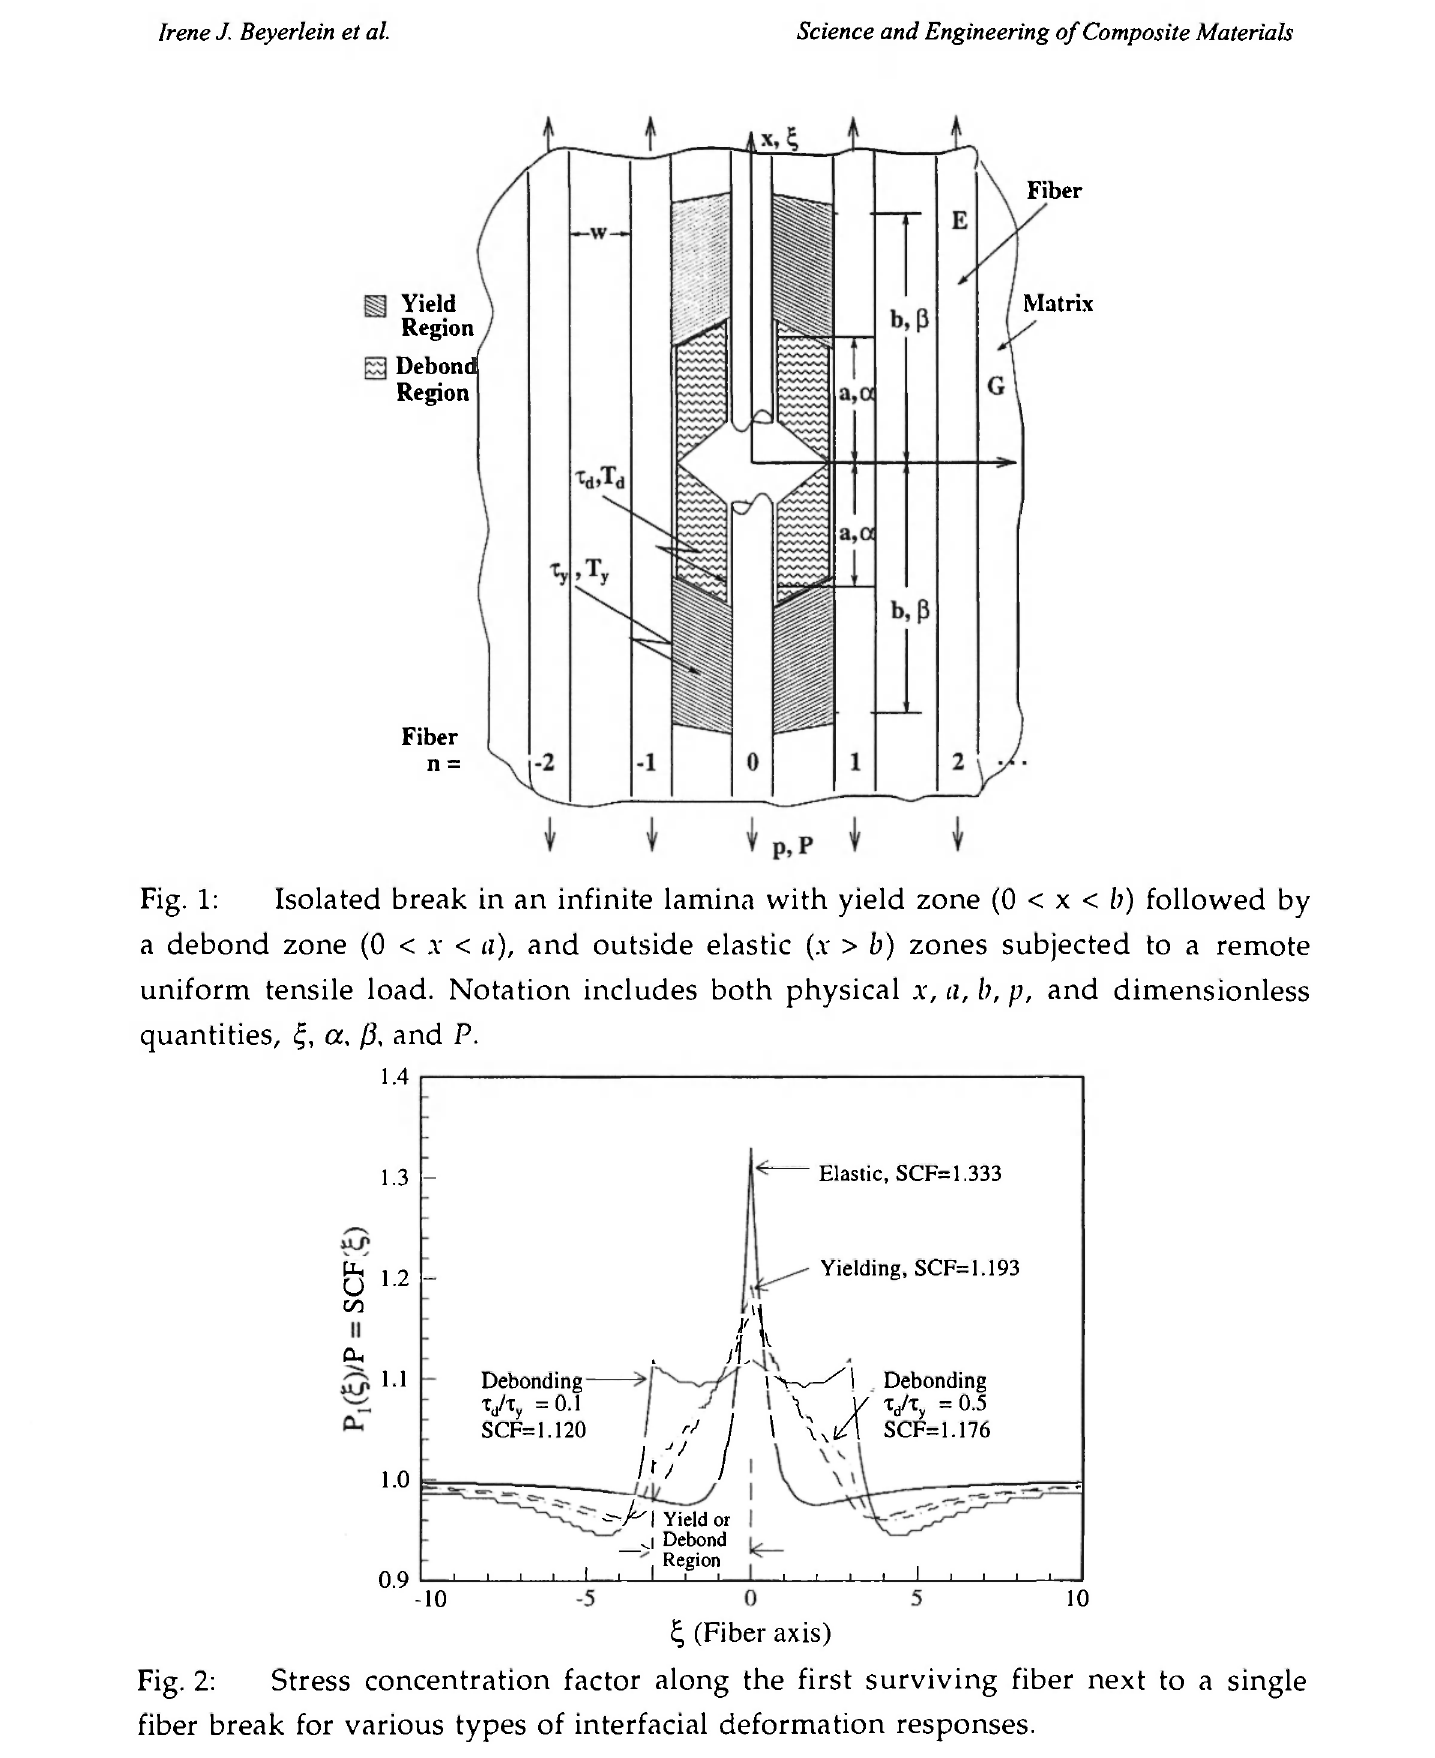
Fig. 2: Stress concentration factor along the first surviving fiber next to a single fiber break for various types of interfacial deformation